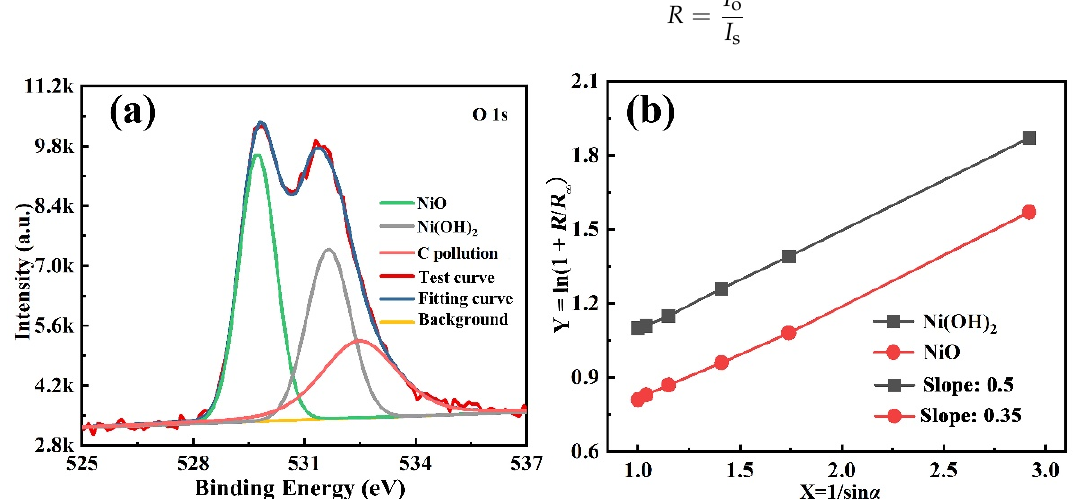
Figure 6. ( a ) ARXPS spectra of O 1s photoemission and the fitting results, ( b ) the results of ln(1 + R / R ∞ ) against 1/sin α for the nickel oxides in NiFe thin film.